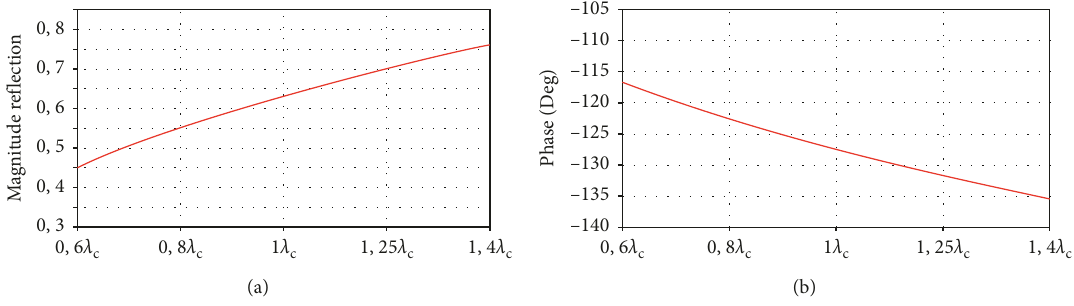
Figure 4: Reflection coefficient of a periodic FSS: (a) magnitude; (b) patch antenna. For example, for such optimizations, con- It can be observed in another optimization of the res- sider the S onance frequency versus the height of the cavity, as shown in parameter and impedance evolutions 11 Figure 6(b), that the second and third resonance frequencies (Figure 6(a)) as a function of the frequency for different are very sensitive to the variation in the heights of cavity, and patch lengths. When the patch length is varying, the 2 EBG it is also seen that we can shift both the second and third modes are more or less excited. A good compromise is resonances towards the first resonance frequency. obtained when the length of patch is 0.29 λ . c